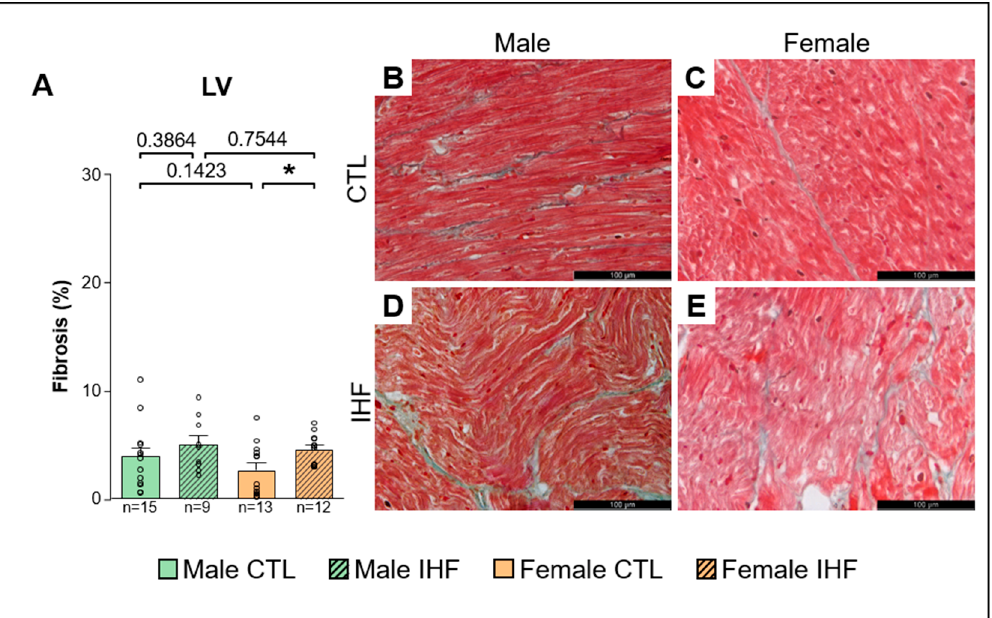
Figure 10. Interstitial fibrosis assessed by Masson‘s trichrome staining in the Left Ventricle (LV). ( A ), LV Fibrosis. ( B , C ), Representative images of control pigs in the LV of males ( B ) and females ( C ). ( D , E ), Representative images of IHF pigs in the LV of males ( D ) and females ( E ). CTL , control animals without ischemic heart failure; IHF , animals with ischemic heart failure. Bar graphs represent Mean + SEM, grey circles represent data of individual pigs. Mann-Whitney-U Test. * p < 0.05.